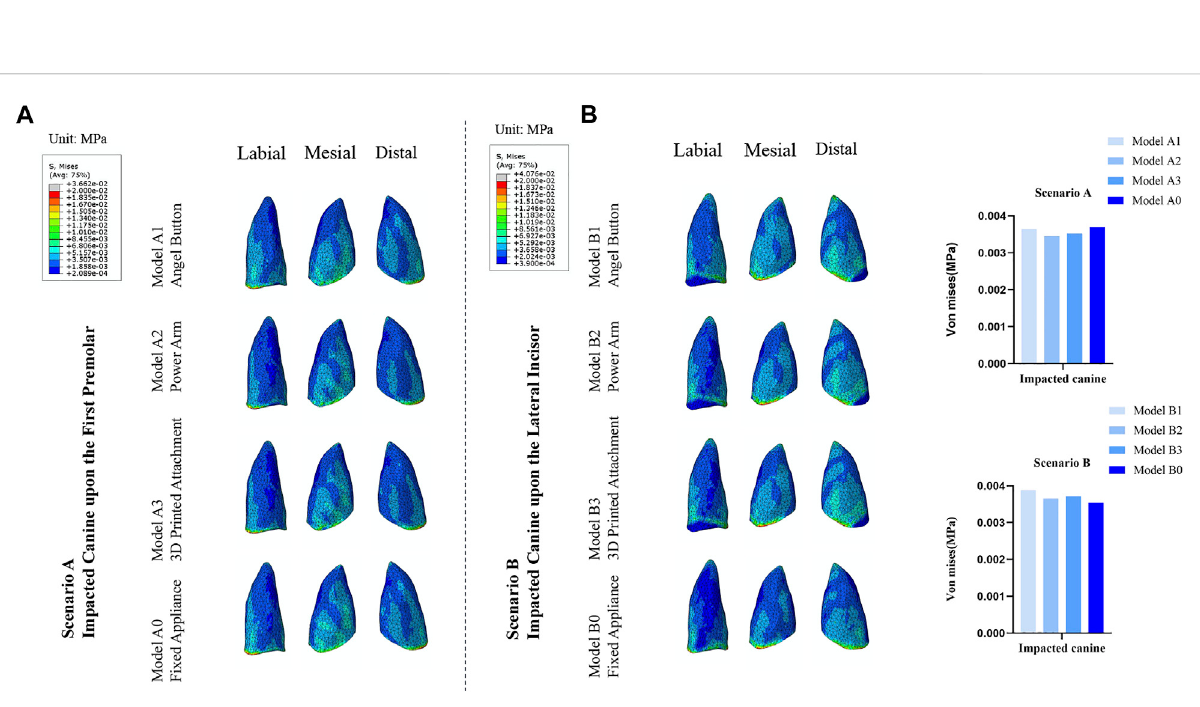
FIGURE 4 (A) ThevonMisesdistribution(bluetograyre fl ectslowertohigherstress)inthePDLoftheimpactedcanineinresponsetothedifferenttraction models of Scenario A and Scenario B. (B) Stress value for average von Mises in the PDL of the impacted